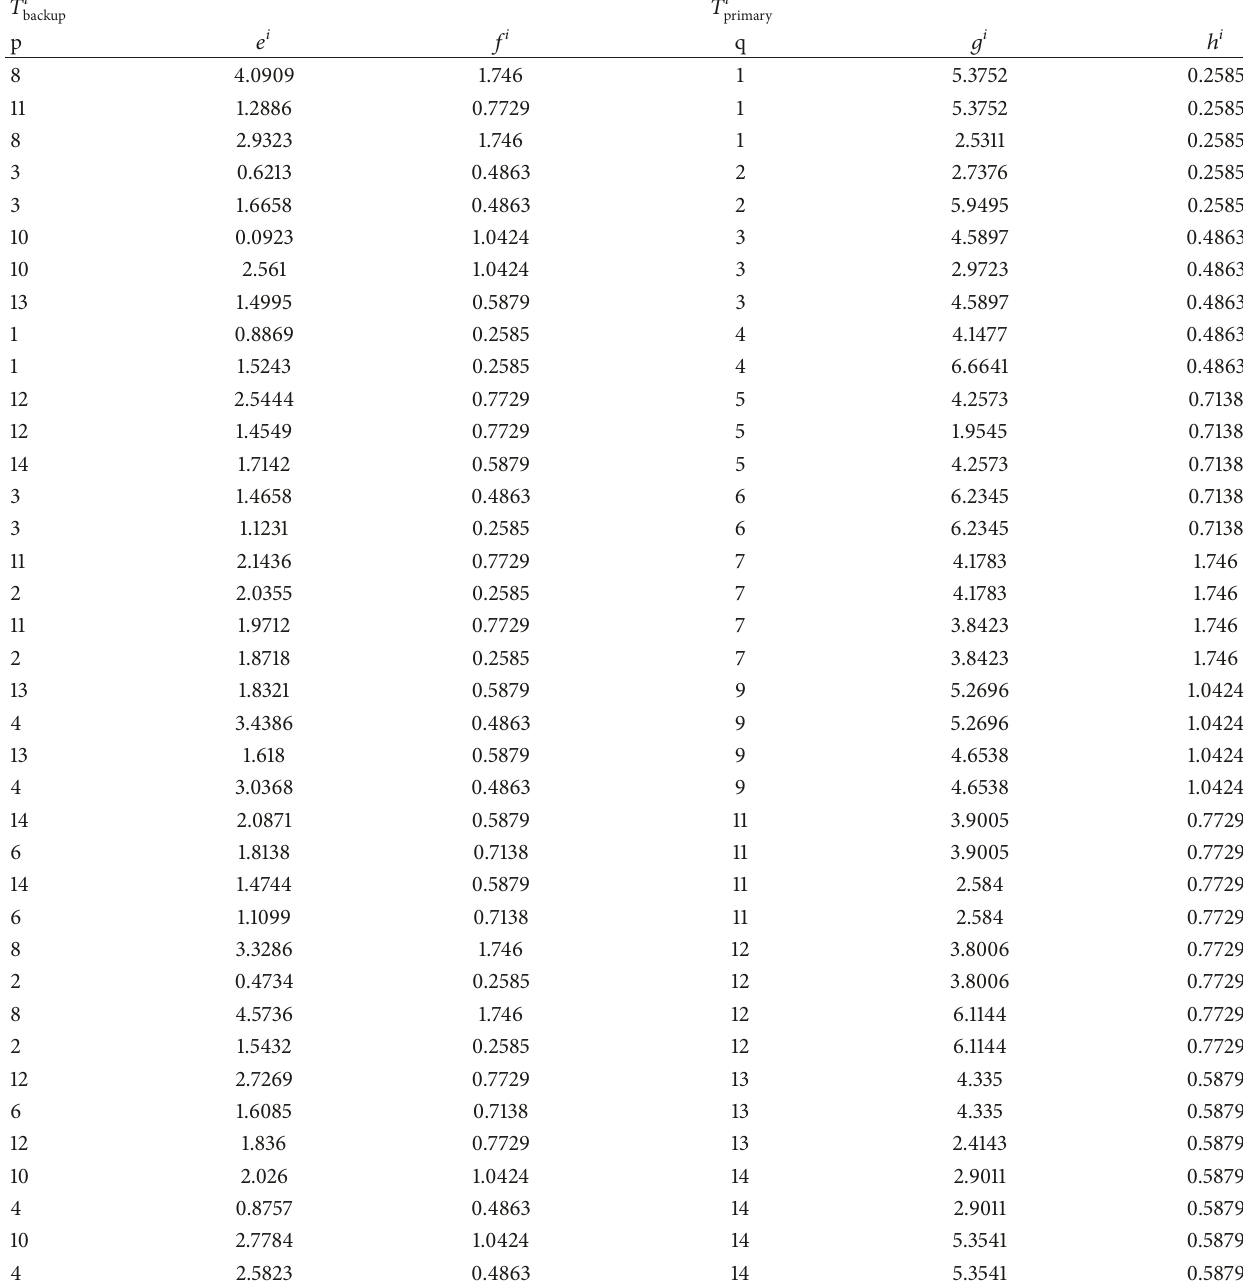
Table 12: Values of constants 𝑒 𝑖 ,𝑓 𝑖 , 𝑔 𝑖 , and ℎ 𝑖 for Model